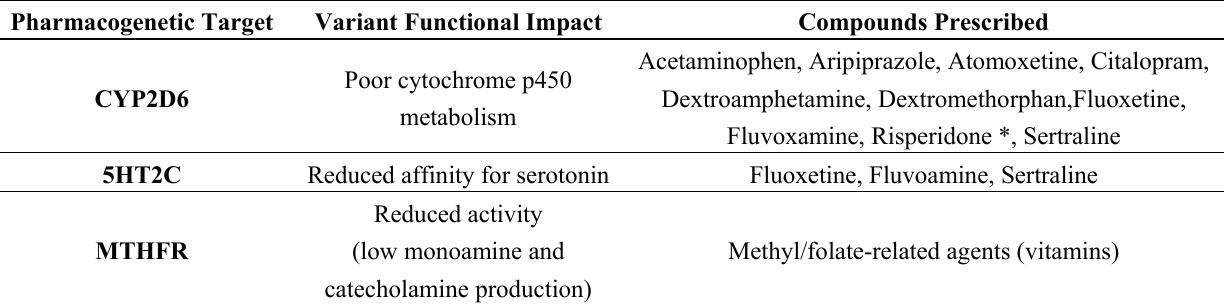
Table 2. Pharmacogenetic test results with drug interactions from our clinical